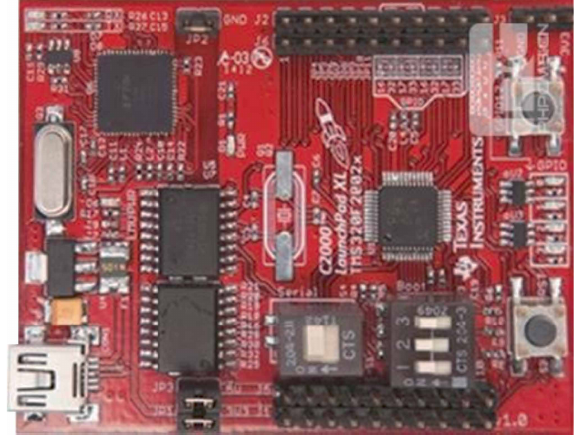
Figure 16: Control circuit